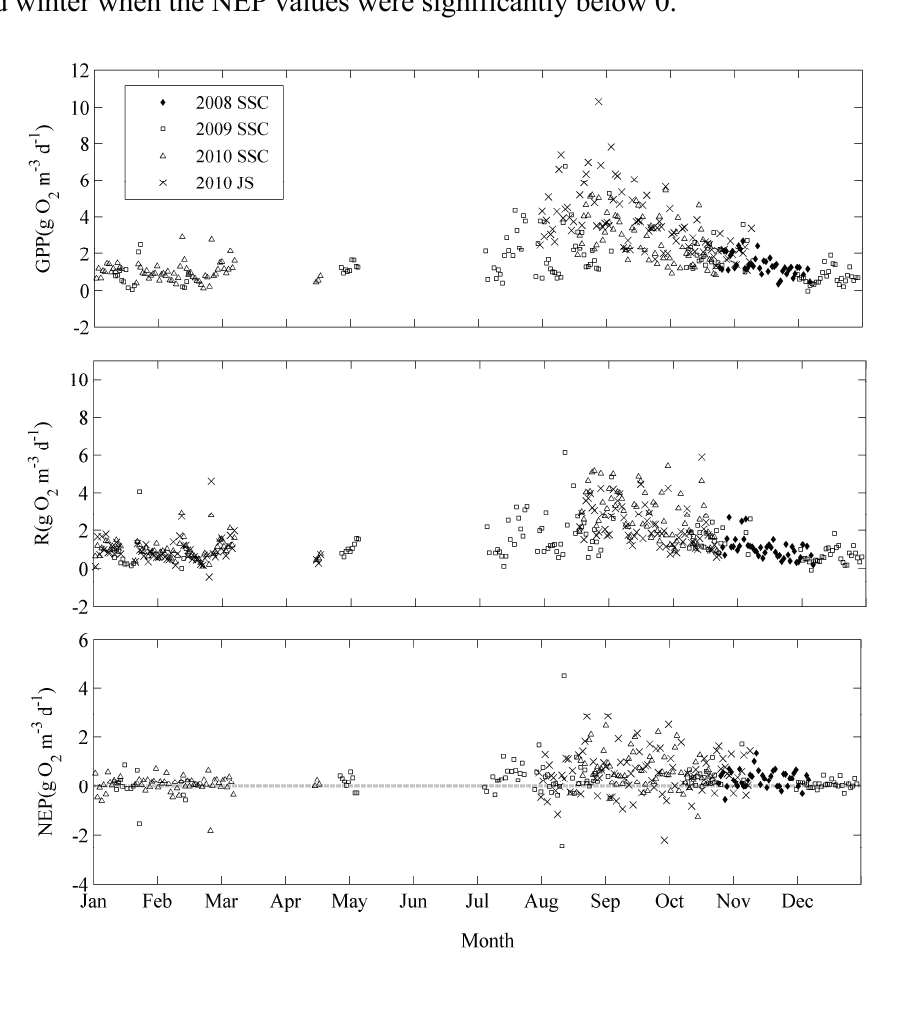
Figure 4. The temporal dynamics of gross primary production (GPP), ecosystem respiration (R), and net ecosystem production (NEP) rates at Shangshancun (SSC) and Jinshu (JS) buoy